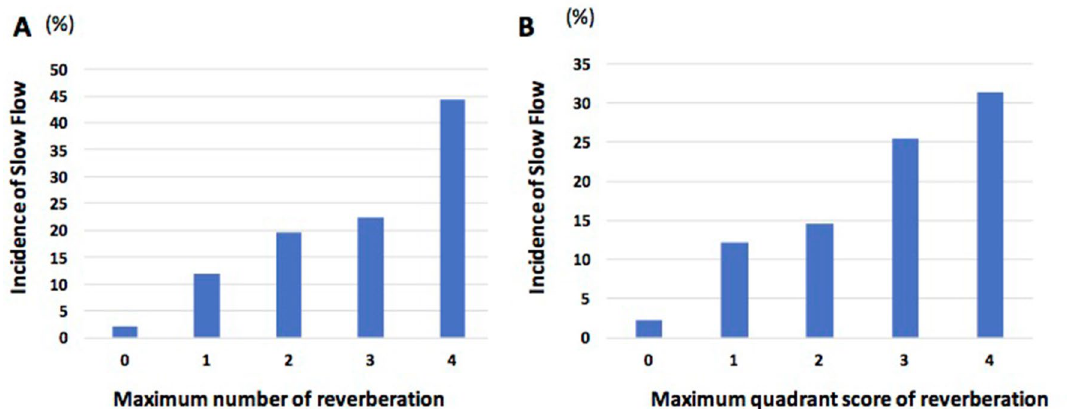
Figure 3. Association between reverberations and incidence of slow flow immediately after RA. ( A ) The graph showed the association between the maximum number of reverberations and slow flow. ( B ) The graph showed the association between the maximum quadrant score of reverberations and slow